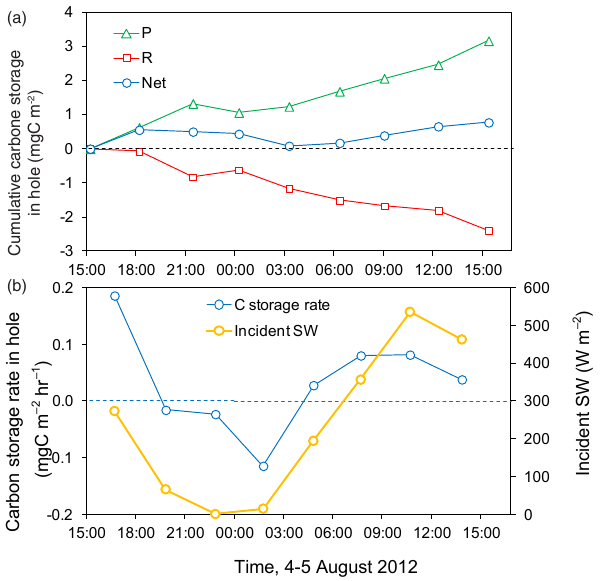
Figure 12. Changes in cryoconite hole C storage at sub-diurnal time scales. (a) Cumulative C storage as measured in bottles incubated for 3 to 24h. (b) Equivalent C flux in the same bottles as part (a) , plotted alongside incident shortwave radiation intensity (3-h aver- ages of 30-min data).